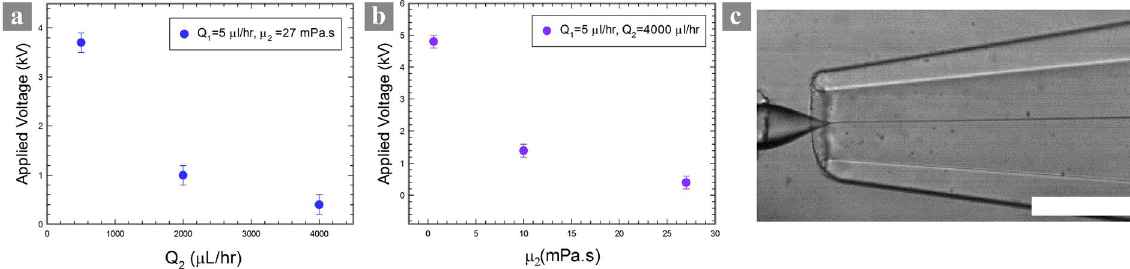
Figure 2. The onset applied voltage at which a sharp cone forms decreases with an increasing ( a ) flow rate or ( b ) viscosity of the outer phase; In plot ( a , b ), all the other parameters are kept constant, and the outer phases with different viscosities are hexadecane (1.5 mPa.s), silicone oil (10 mPa.s) and squalene (27.8 mPa.s), respectively. ( c ) With sufficiently large shear stress from the outer phase to overcome capillary pressure, a sharp cone is observed without applied electric voltage. The outer phases are paraffin oil (40 mPa.s) with 5% EM 90 with a flow rate of 2000 μ l/hr. The scale bar is 200 µ m.